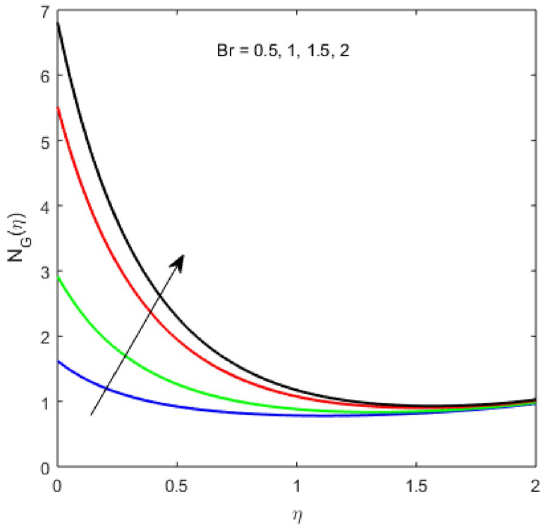
Figure 16. Entropy generation variation for increasing Br .